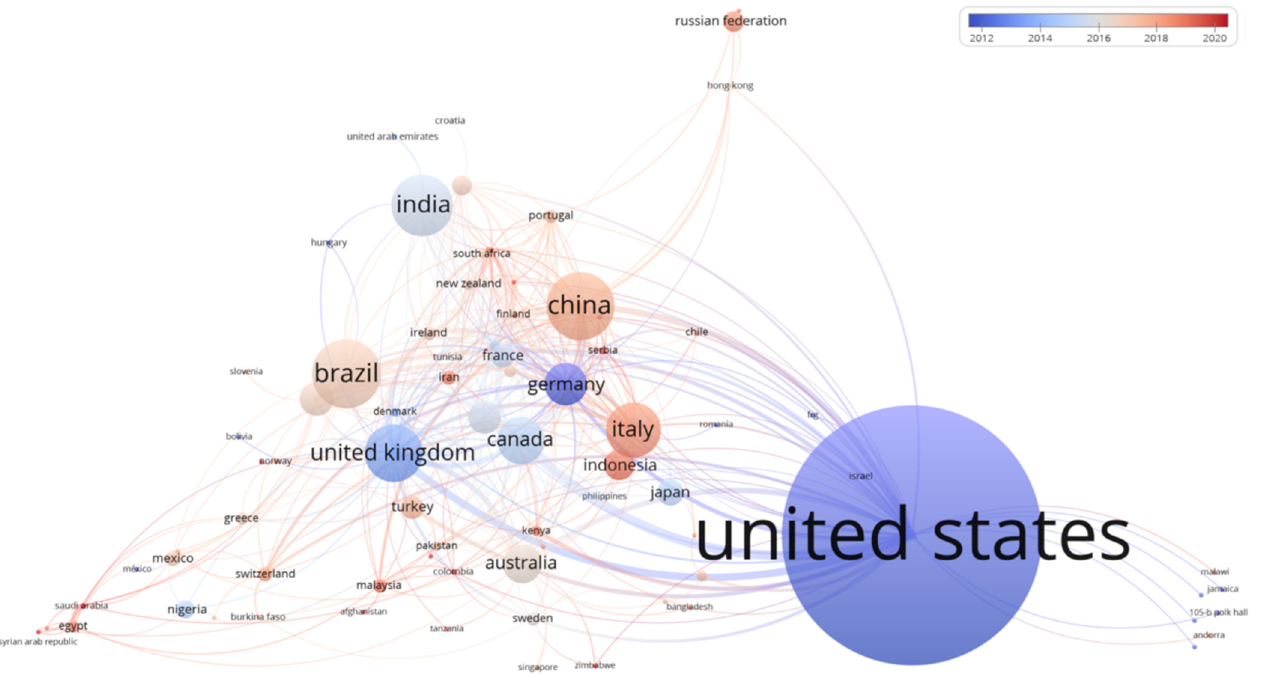
Figure 2. Co-authorship map showing the geographical distribution of publications over time. The prominence of the circles and texts in each cluster represents the number of publications from that country, while the distance of the elements and the connecting lines explain the relationships and potential connections between different co-authors. Finally, the different colors represent the publication period, ranging from 2012 (blue) to 2022 (red).